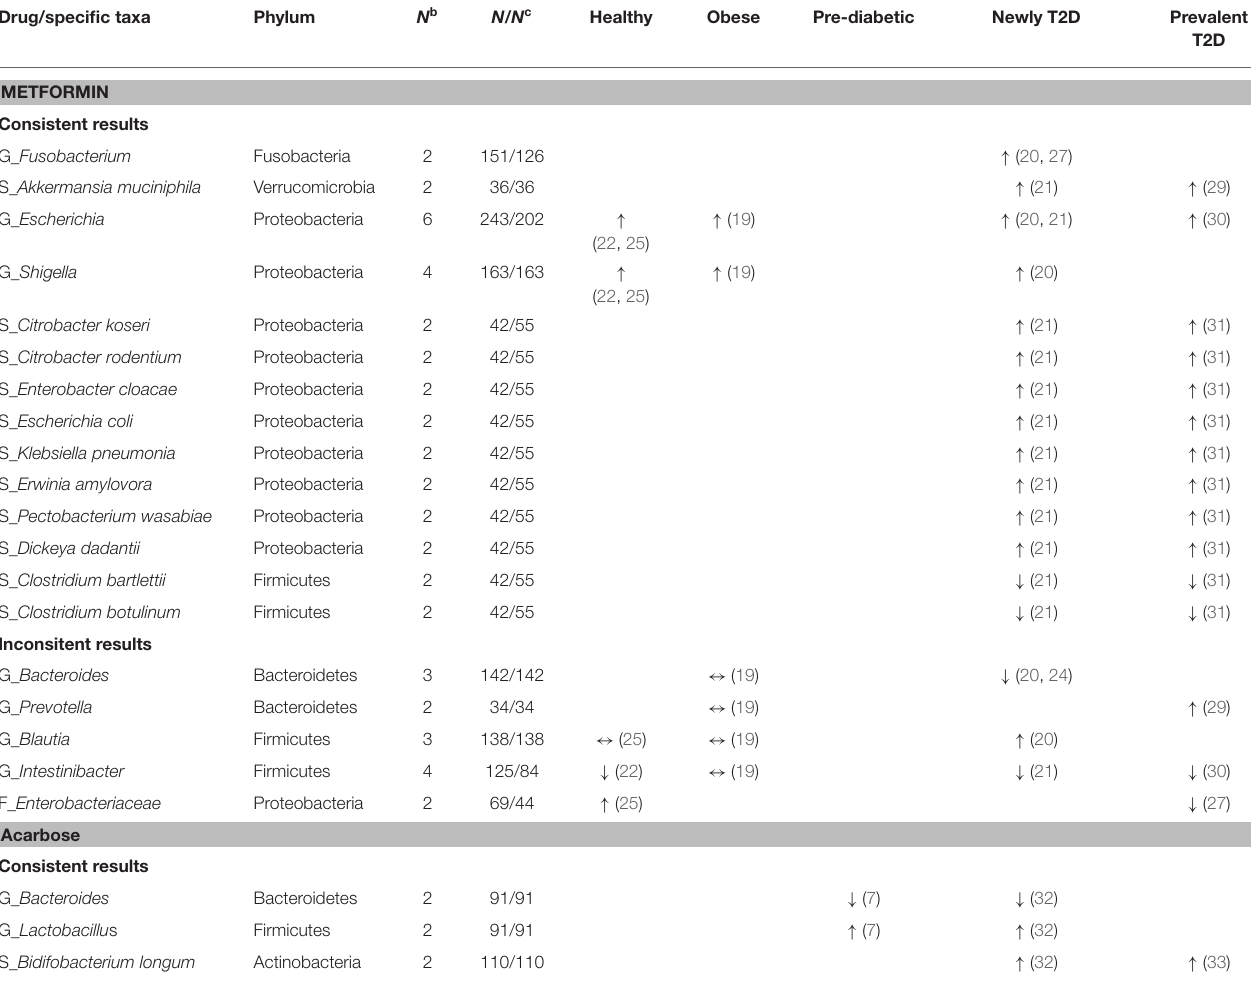
TABLE 5 | Consistent and inconsistent effects of each anti-hyperglycemic drug on specific taxa in human gut microbiota, categorized by the target research populations a . Drug/specific taxa Healthy Obese Pre-diabetic Newly